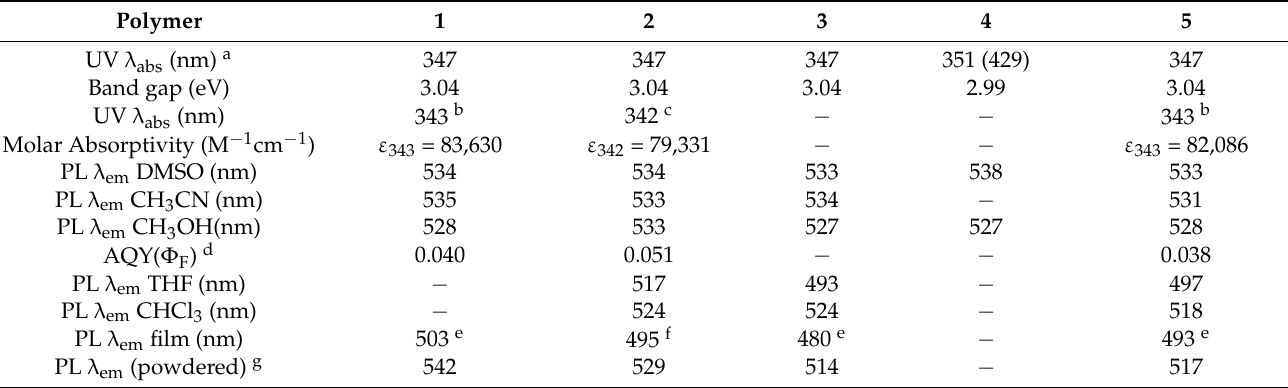
Table 4. Optical properties of poly(pyridinium salt)-fluorenes, 1 – 5